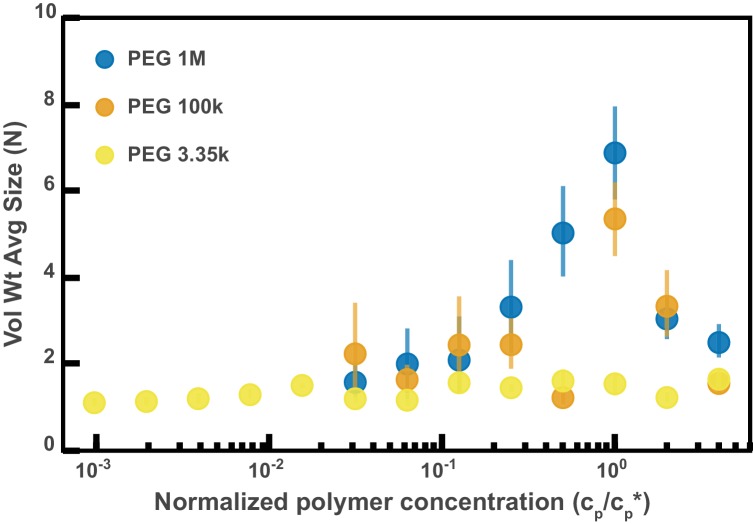
Aggregation of PEG-coated particles in model polymer solutions from Figure 4D normalized by polymer overlap concentration.Volume-weighted average sizes for serial dilutions of 1 MDa PEG solutions in Hanks' balanced salt solution (HBSS). Volume-weighted average sizes are plotted on the vertical axis in units of number of particles per aggregate (N) against the ‘normalized polymer concentration.’ The normalized polymer concentration is the polymer mass concentration (cp) in mg/mL divided by the overlap concentration of each polymer solution (cp*) in mg/mL. The overlap concentrations for PEG 1 MDa, 100 kDa, and 3350 Da are cp*=1.6, 8.6, and 52.6 mg/mL, respectively. The vertical error bars are 95% empirical bootstrap CI (see Materials and methods for bootstrapping procedure).